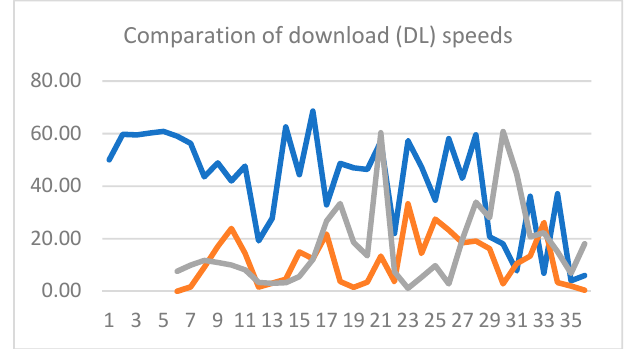
Figure A5. Comparison of download speeds (MDMG).